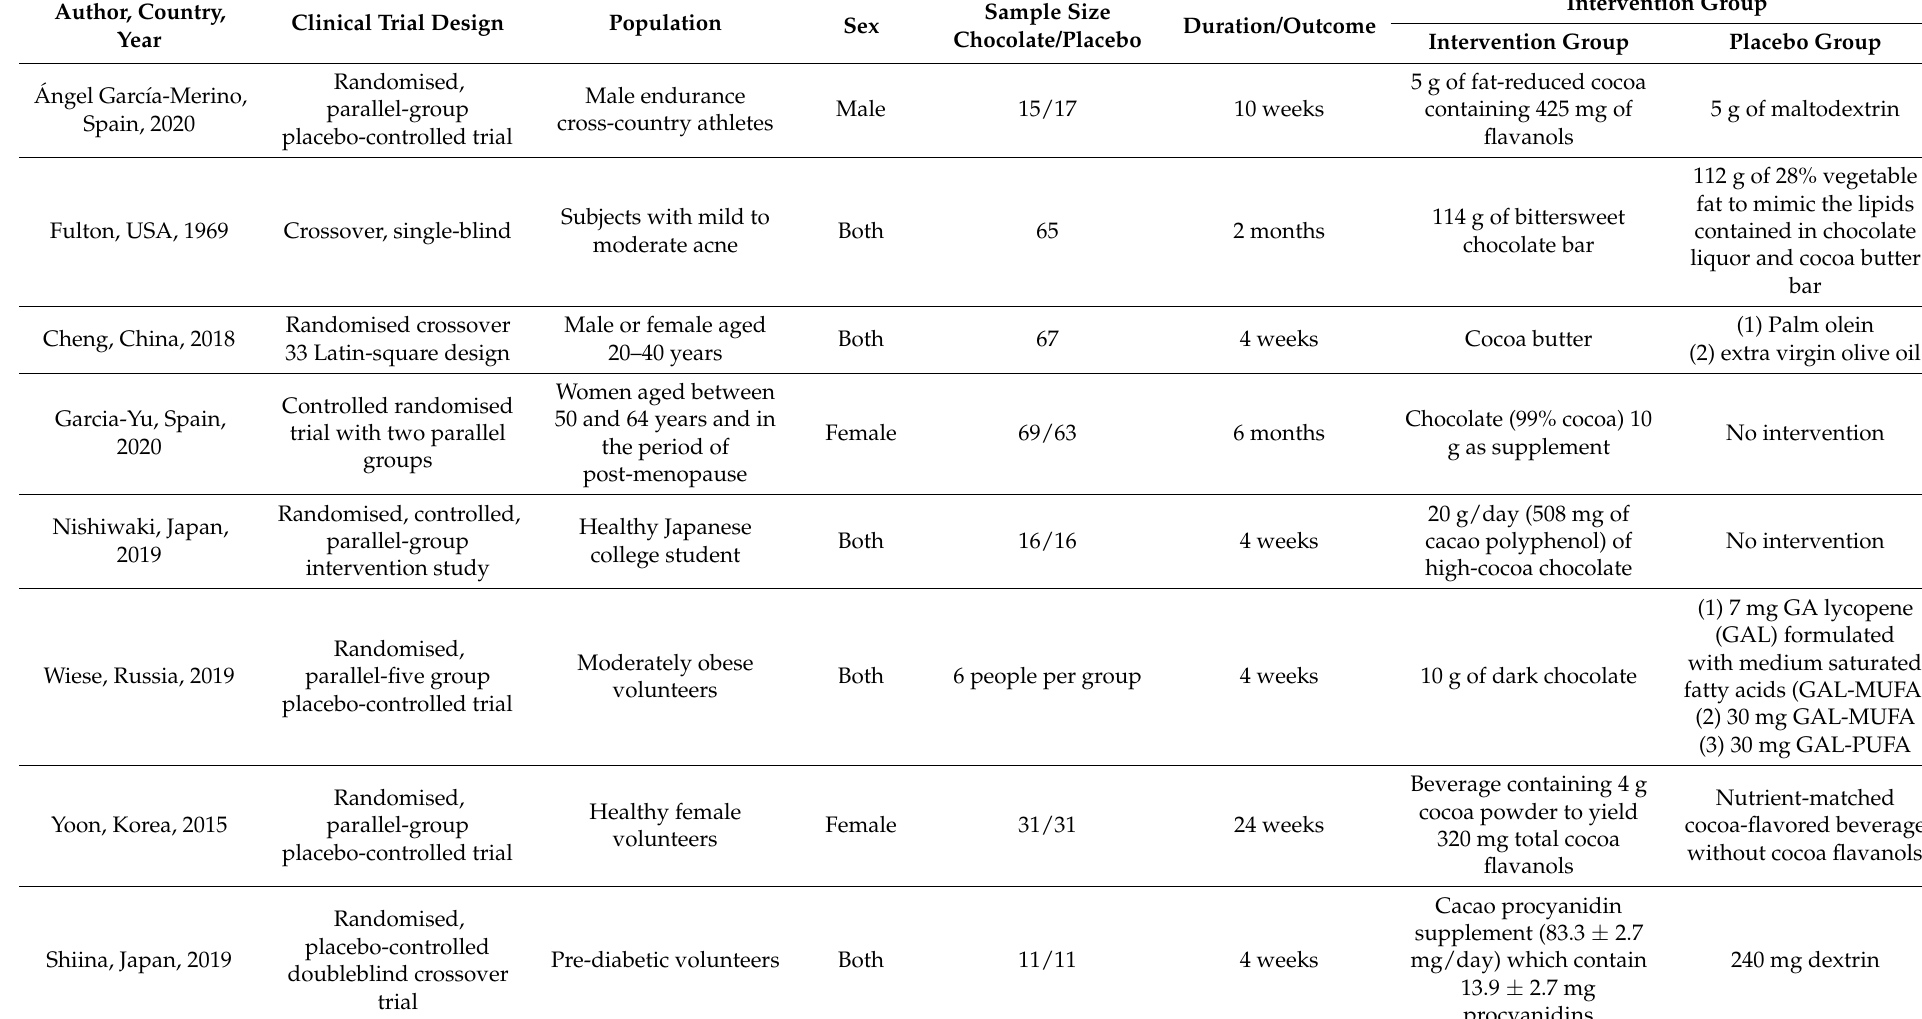
Table 1. Characteristics of included